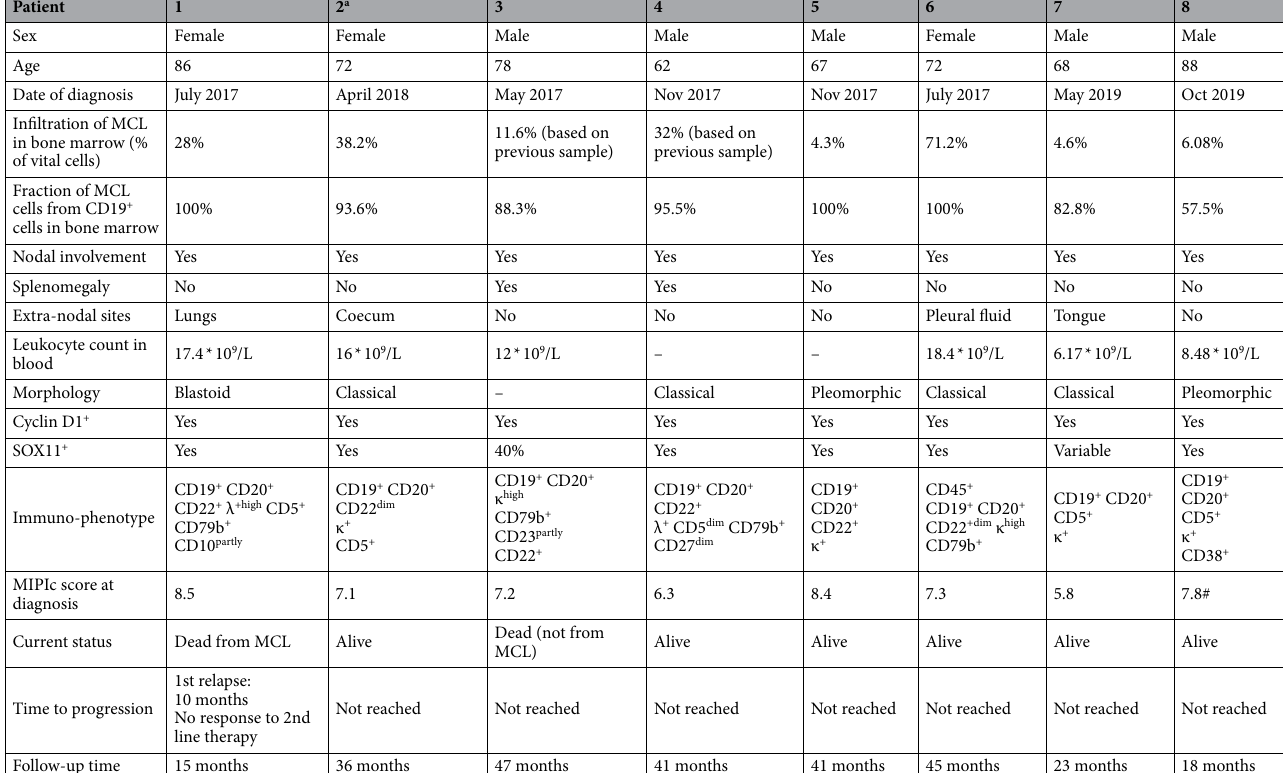
Table 1. Clinical patient information. Patient information was obtained from the clinical records. MCL infiltration was determined by flow cytometry analysis of bone marrow (BM) cells and calculated as percentage of the vital cells in the sample. The fraction of MCL cells from CD19 + cells was calculated, based on the flow cytometry clinical laboratory data, by dividing the percentage of all CD19 + cells including MCL cells, non-malignant B cells and plasma cells ( ∼ 70% of plasma cells weakly express CD19) by the percentage of monoclonal CD19 + cells in the BM sample. In all patients, the MCL cells were positive for CD19 and CD20 and showed immunoglobulin light chain restriction. All patients had nodal involvement, bone marrow involvement, and were positive for both cyclin D1 and SOX11 as evaluated by immunohistochemistry staining of lymphocytes in lymph node and bone marrow biopsies. Apart from this, the patients were, in consistence with the pathology of MCL, heterogeneous in their clinical presentation. a Patient 2 had a